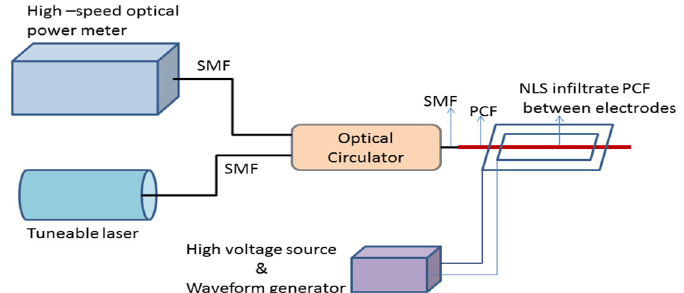
Figure 29. Schematic of the experimental setup to study reflected power response of the nematic liquid crystal (NLS) infiltrated PCF probe for the measurement of external electric field intensity (Reproduced from [96], with the permission of OSA publishing).